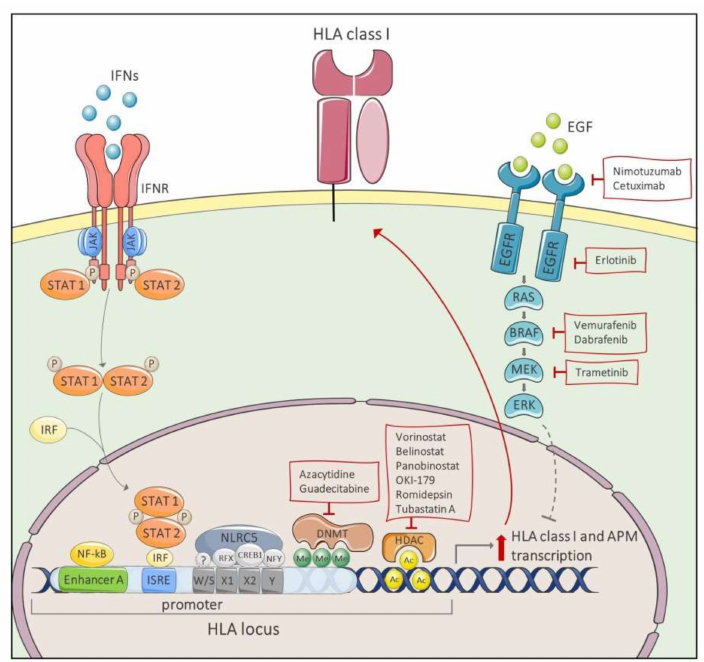
Figure 2. Mechanisms for restoring HLA class I expression. IFN binding to IFNR triggers Jak / STAT transduction pathway. STAT1 / STAT2 / IRF complex translocates to the nucleus where it binds to ISRE motifs located in HLA promoter region, inducing HLA gene transcription. EGFR and MAPK down-streampathwayssuppressHLAclassIsurfaceexpression. EGFRinhibitors, suchasnimotuzumab, cetuximab and erlotinib, BRAF inhibitors, vemurafenib and dabrafenib, and MEK inhibitor trametinib can increase expression of both HLA class I antigens and APM components. DNMT inhibitors (azacytidine and guadecitabine) and HDAC inhibitors (vorinostat, belinostat, panobinostat, OKI-179, romidepsin and tubastatin A) avoid hypermethylation of HLA promoter region and histones hypoacetylation that cause HLA genes silencing. Abbreviations: HLA, human leukocyte antigen; IFNs, interferons; IFNR, interferon receptor; IRF, IFN regulatory factor; ISRE, IFN-sensitive response element; EGF, epidermal growth factor; EGFR, epidermal growth factor receptor; DNMT, DNA methyltransferase; HDAC, histone deacetylase; APM, antigen-processing